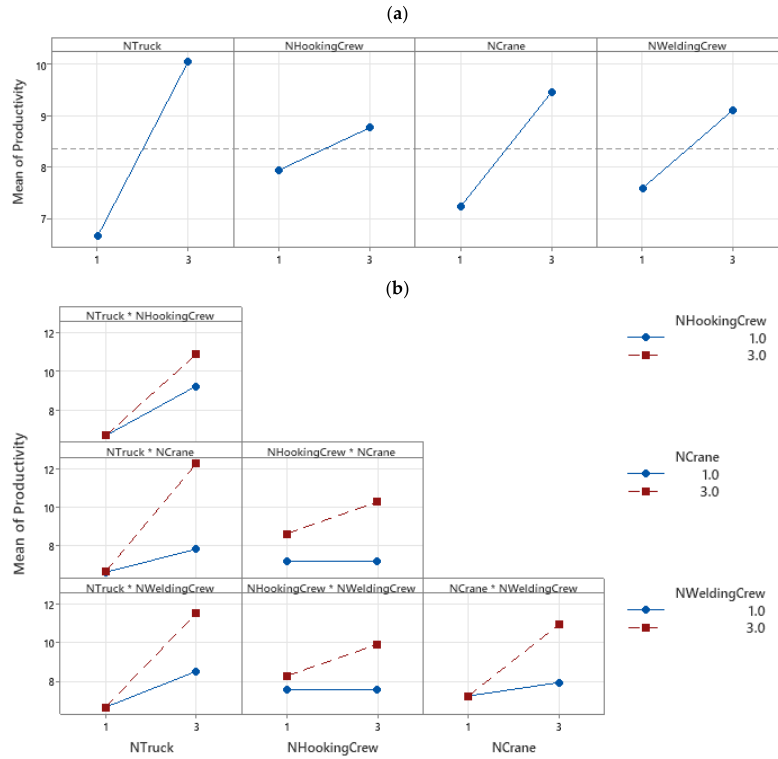
Figure 7. Significant parameters and their interactions on productivity. ( a ) Main effects plot for productivity; ( b ) interaction plot for productivity.